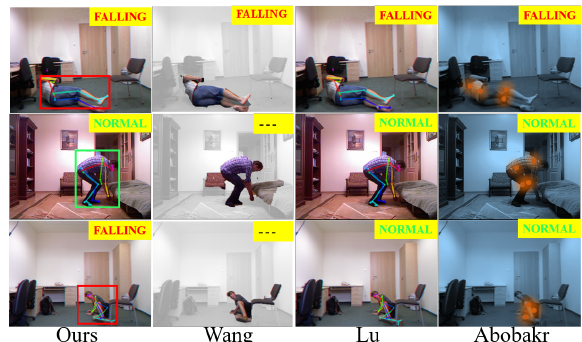
Fig. 7. Comparison of detection effects of different methods.